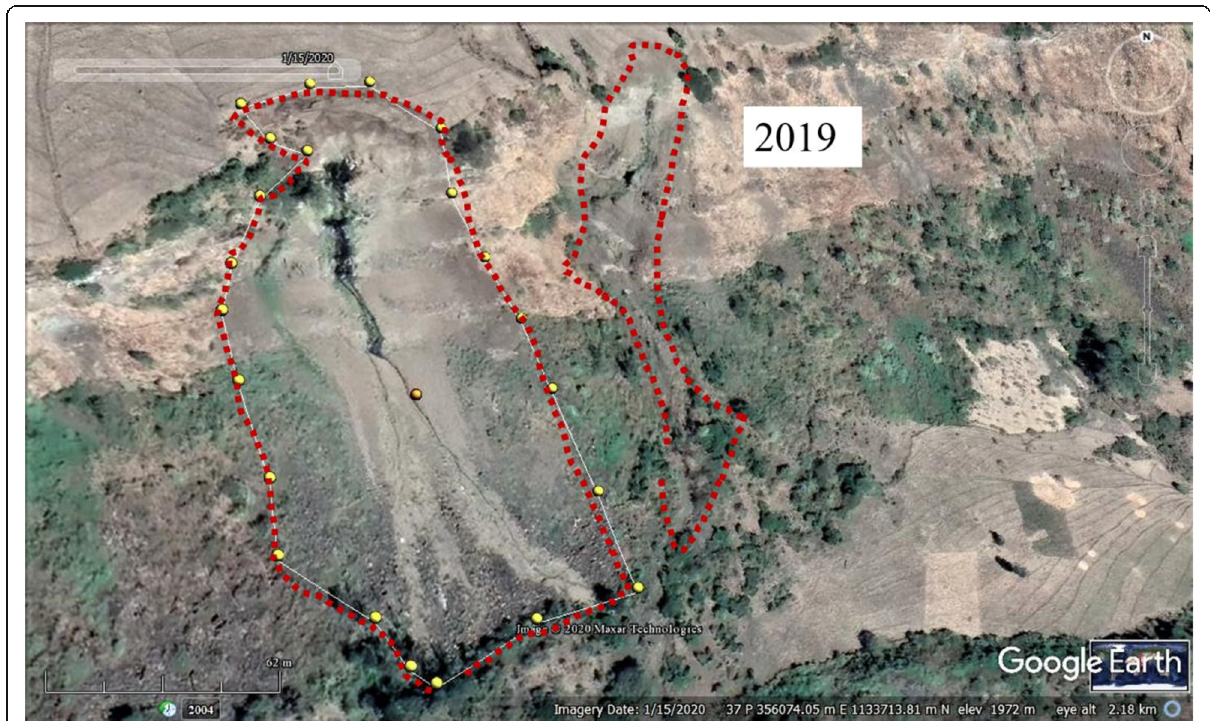
Fig. 7 Time series Google Earth Image shows failed slope at Aba Libanos village in